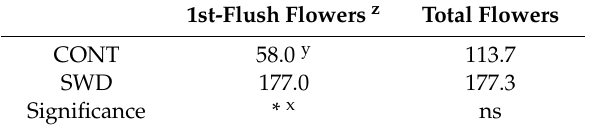
Figure 1. Difference of flowering behavior between control (CONT) ( a ) and soil water deficit (SWD) ( b ) in Meiwa kumquat trees. The number of flowers means the number of flowers that bloomed per day in 10 shoots per tree. Each plot indicates the mean of three replications. Table 2. E ffects of SWD treatment on the number of first-flush flowers and total